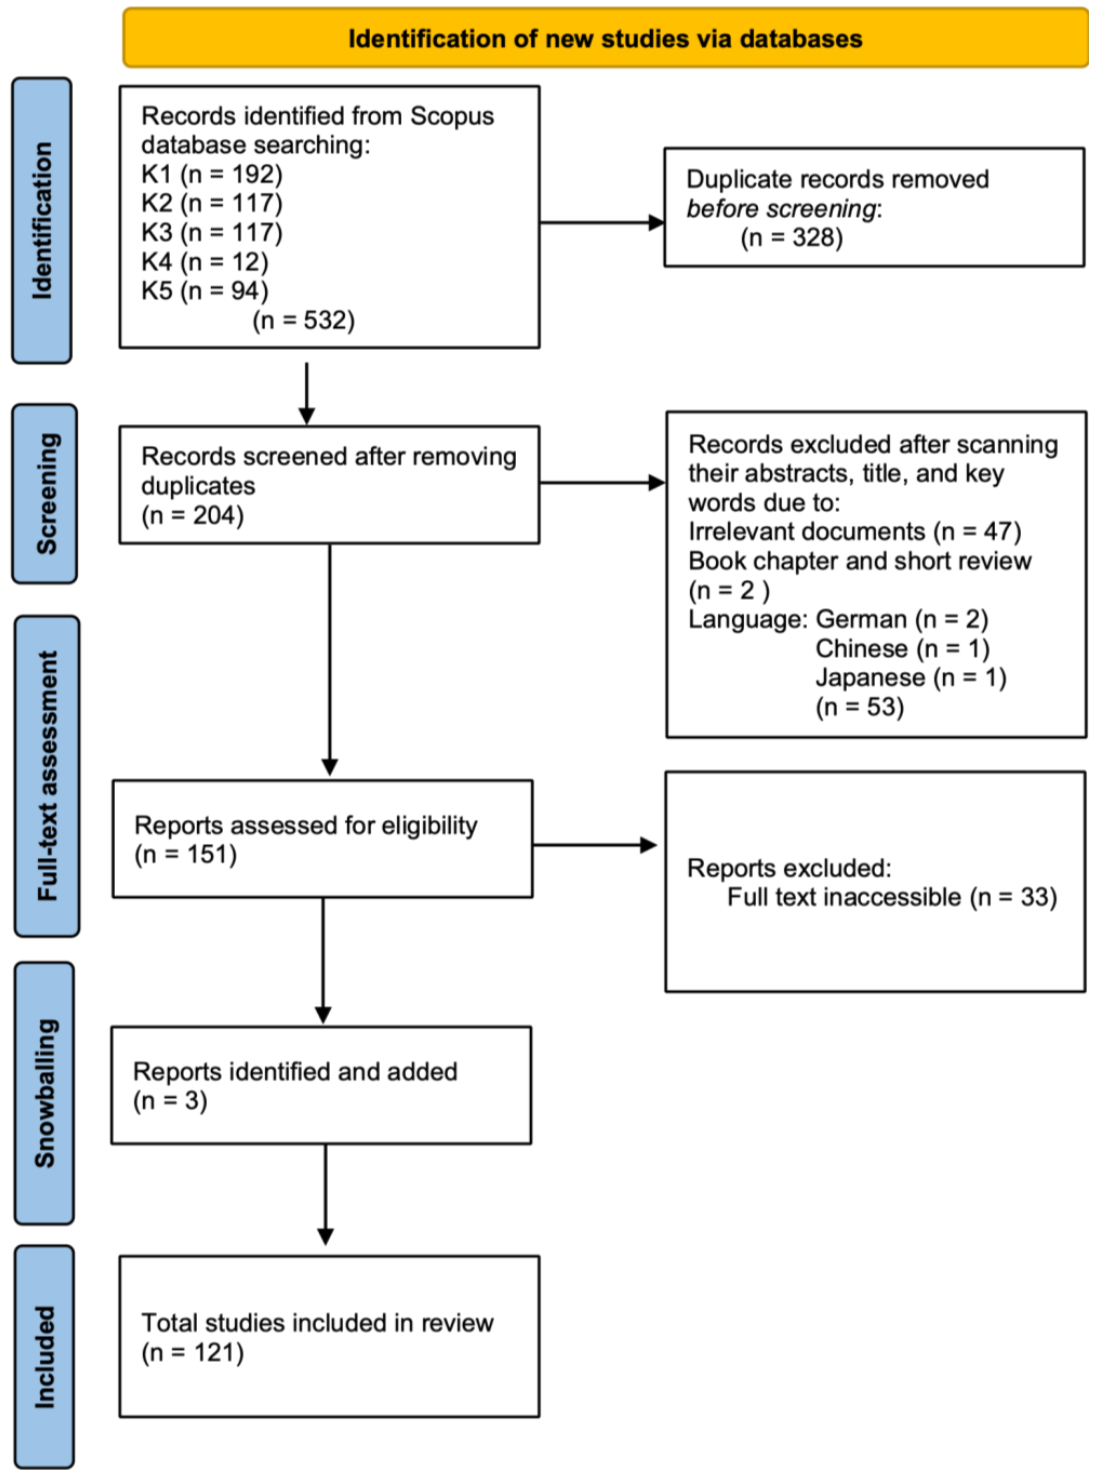
Figure 3. Flowchart illustrating the systematic review process. Source: created by the authors.